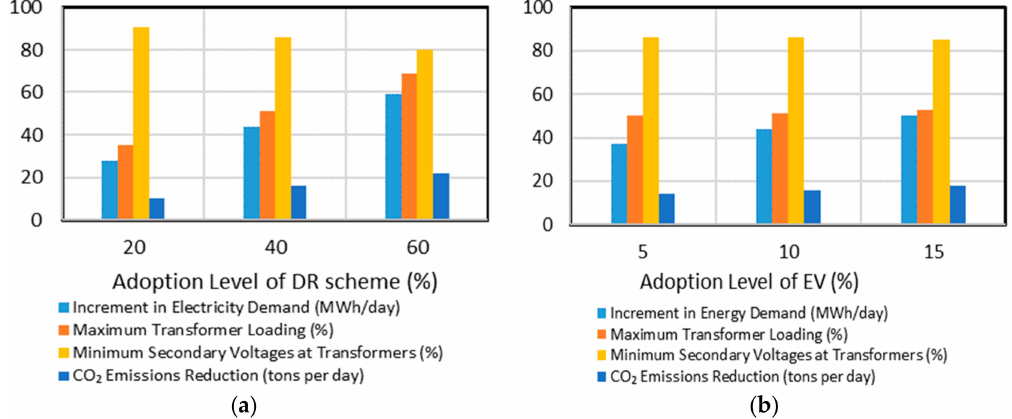
Figure 18. Sensitivity of key variables with respect to the level of adoption of the ( a ) DR scheme for winter and EV adoption level at 10% and ( b ) EV for winter and DR adoption level at 40%.